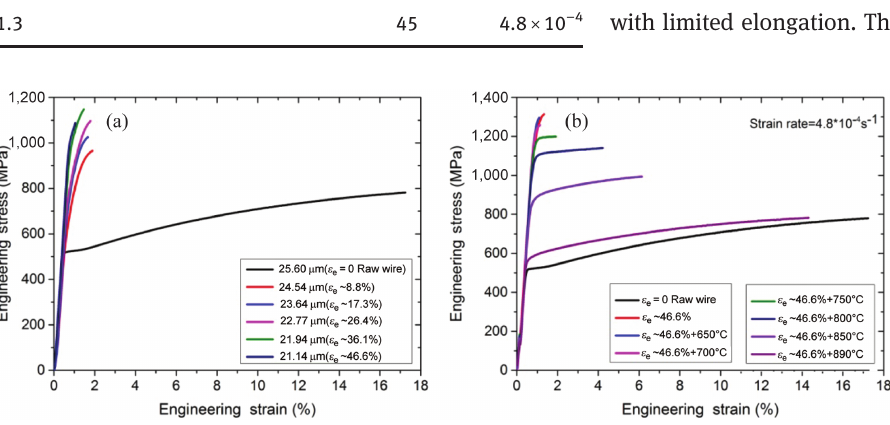
Figure 3: Stress-strain curves of Ni20Cr micro-wires with the different engineering strains and annealing temperatures (the annealing time of 7.3